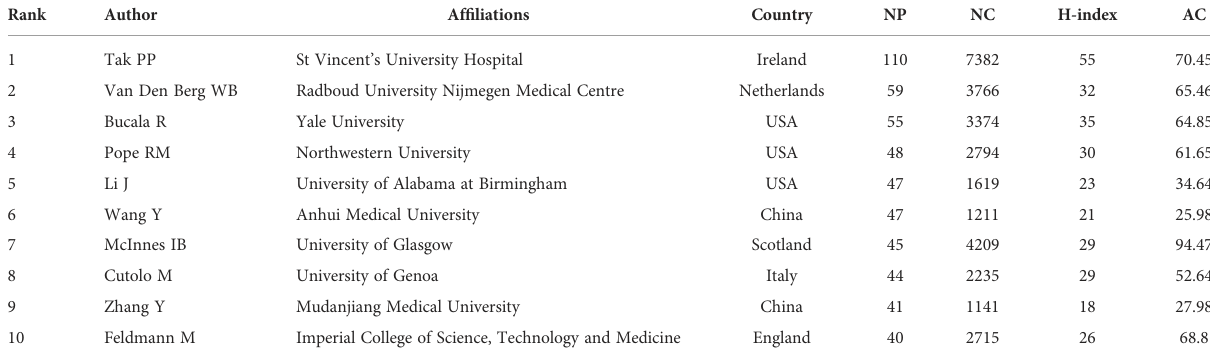
TABLE 4 The top 10 active authors in macrophages-related RA from 2000 – 2021.